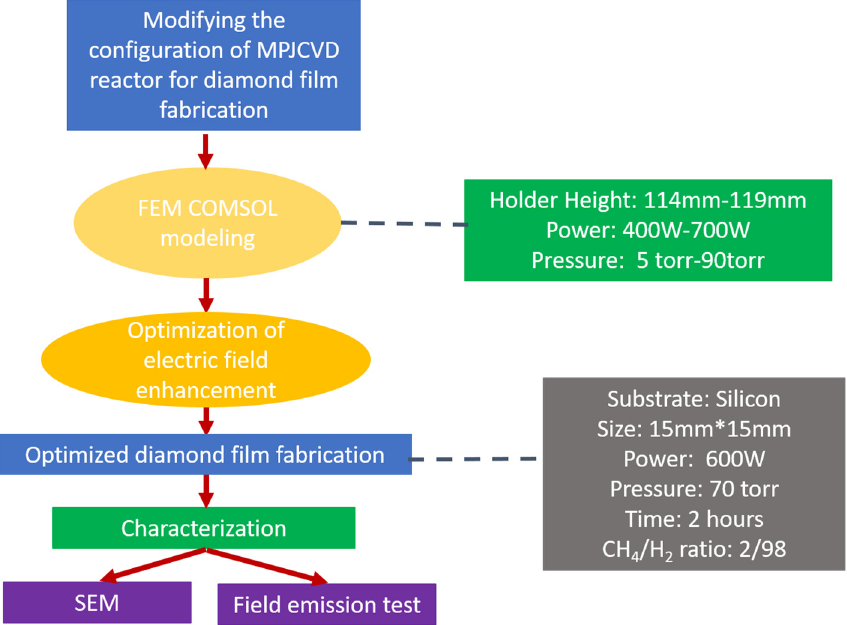
Figure 3. Research flow for the optimization of the MPJCVD chamber configuration with the FEM modeling for diamond film fabrication and characterization